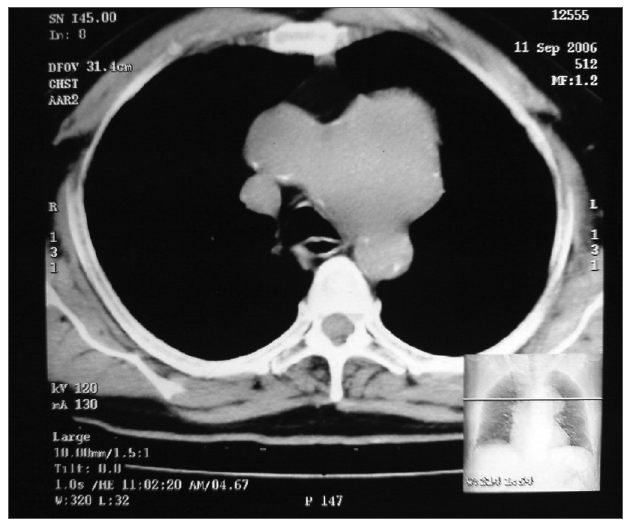
Figure 2. Plain CT scan chest, axial view showing large lobulated mass in the anterior mediastinum.